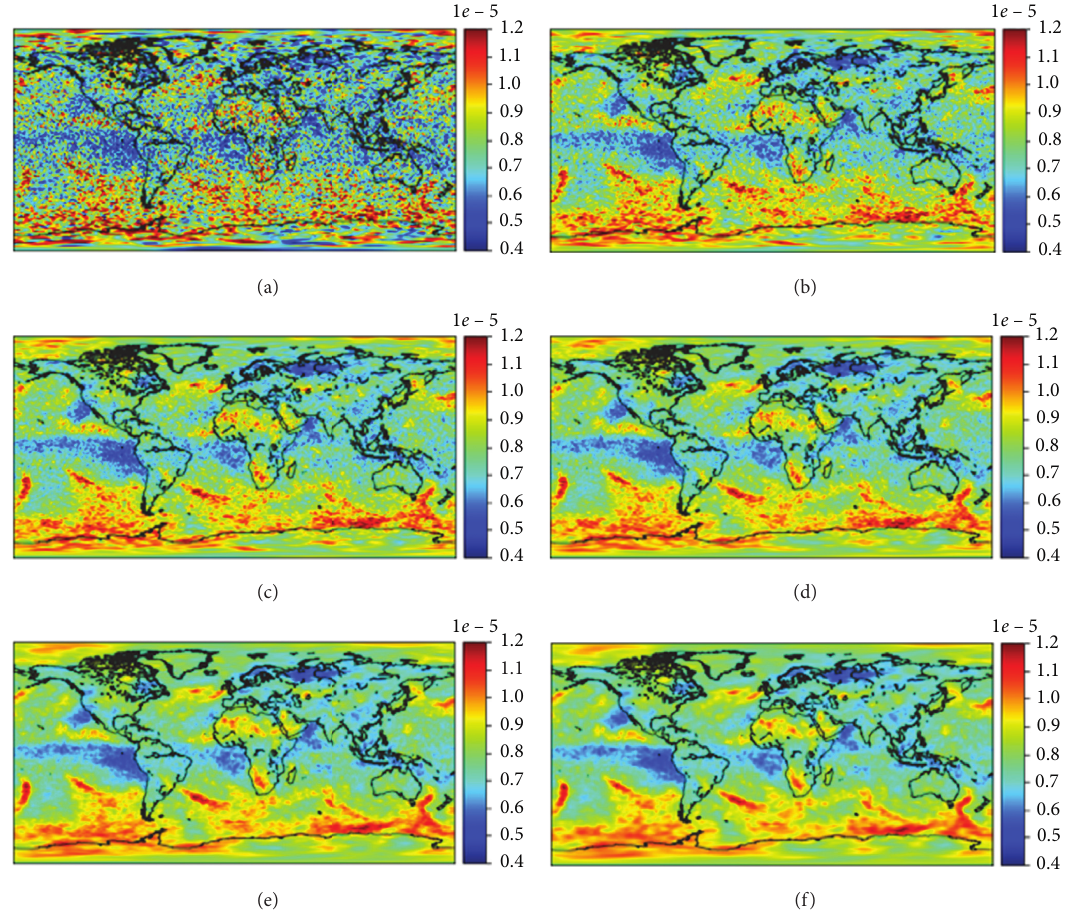
Figure 1: The vorticity standard deviation field at 1000hPa estimated from (a) 10 samples, (b) 50 samples, (c) 100 samples, (d) 200 samples, (e) 1000 samples, and (f) 10000